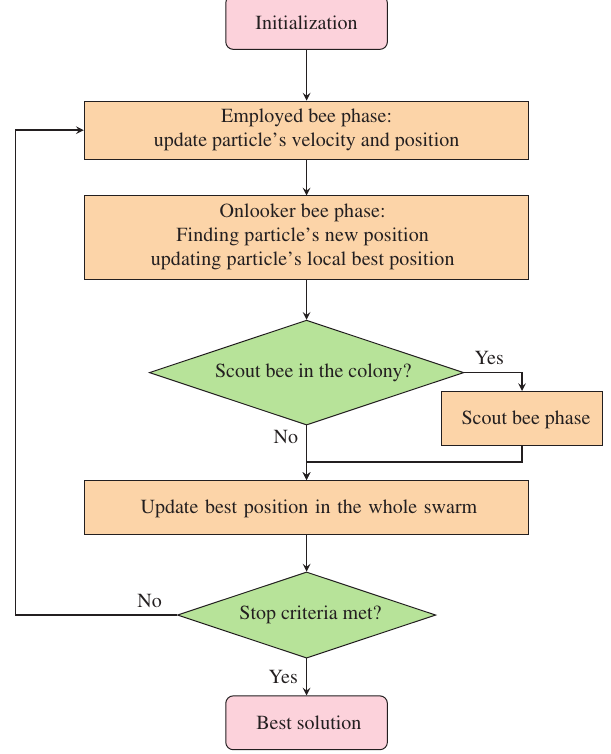
Figure 1: Flowchart of the Proposed